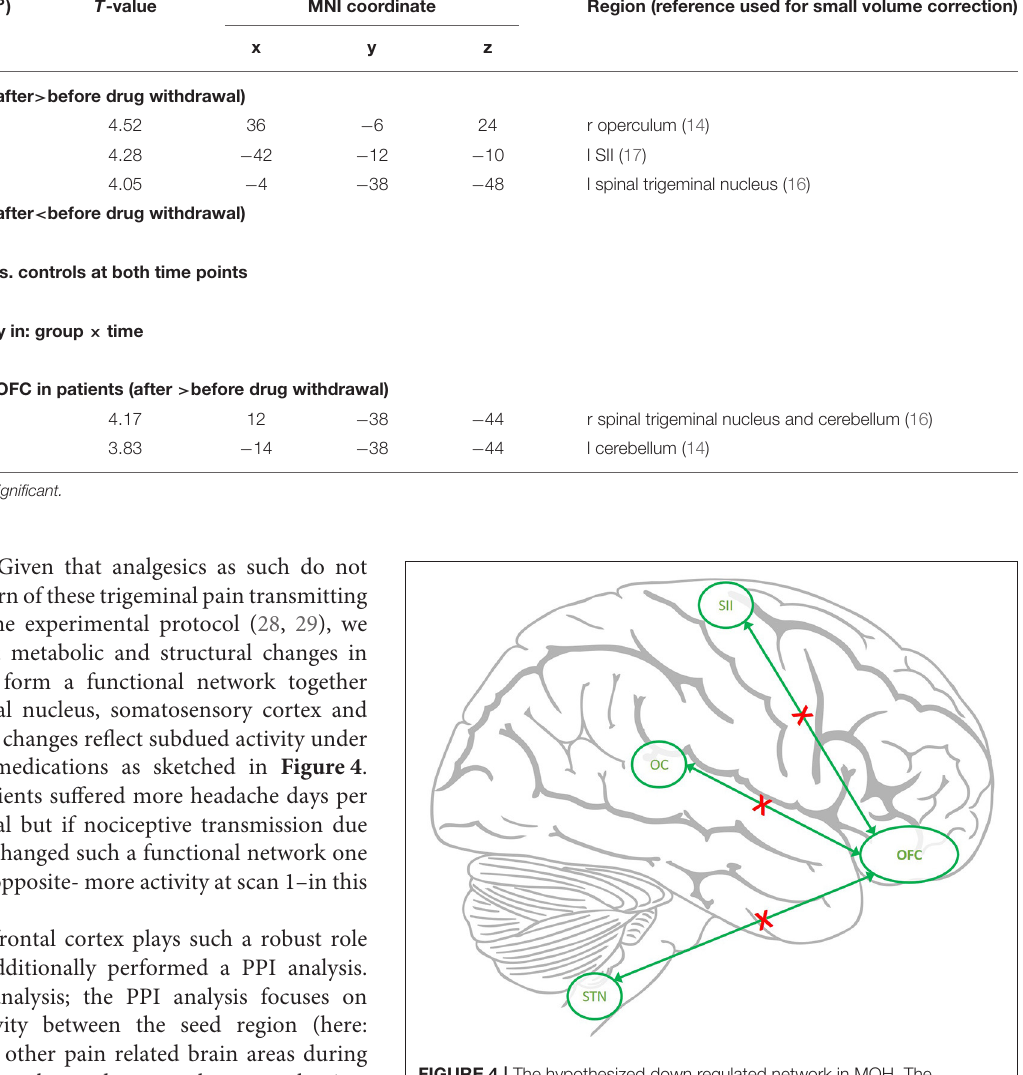
FIGURE 4 | The hypothesized down regulated network in MOH. The connectivity from orbitofrontal cortex (OFC) to spinal trigeminal nucleus (STN), Operculum (OC), and somatosensory cortex (SII) is reduced (red crosses) in MOH but recovers after